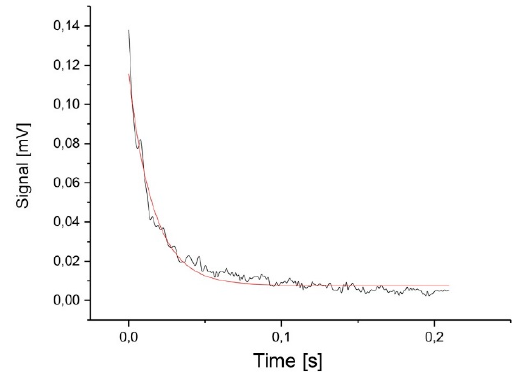
Figure 9. Measured microprobe output signal versus time after multi-frequent excitation of oscillations by a piezo actuator.